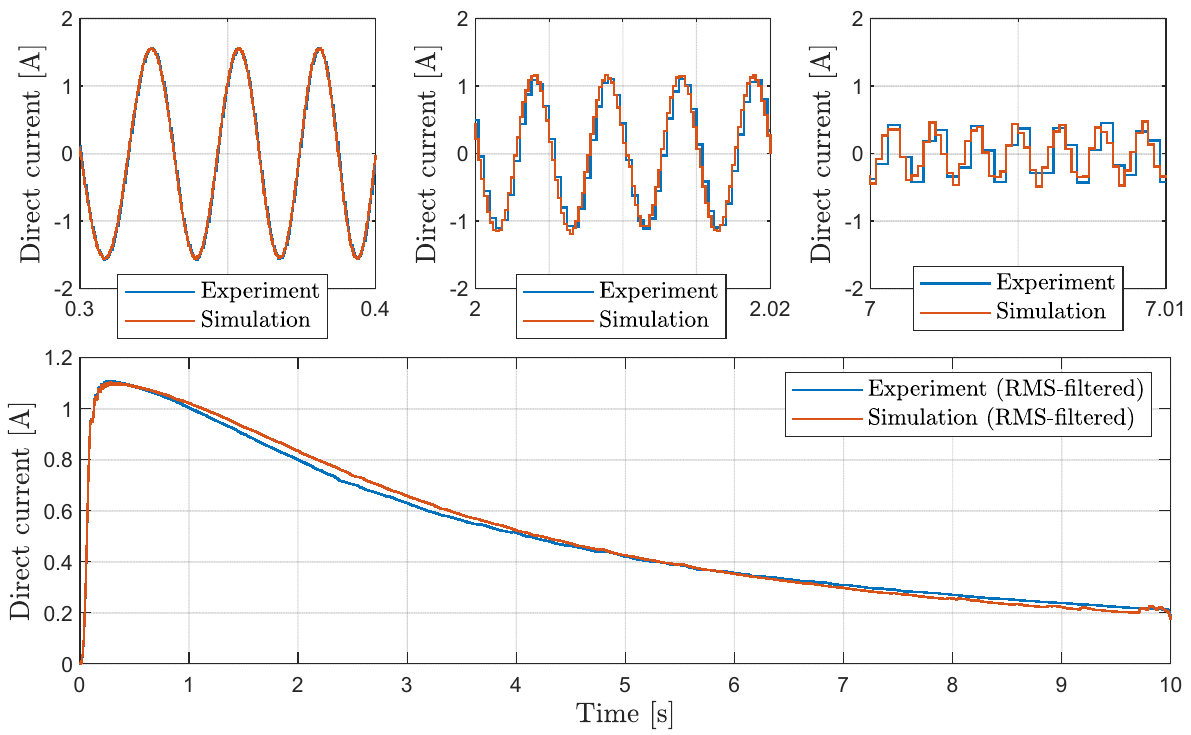
Figure 10. Response to Test 1 (open-loop, engaged brakes, chirp wave input applied on direct voltage demand, ±2 V ranging from 10 Hz, at t = 0 s, to 10 kHz, at t = 10 s).